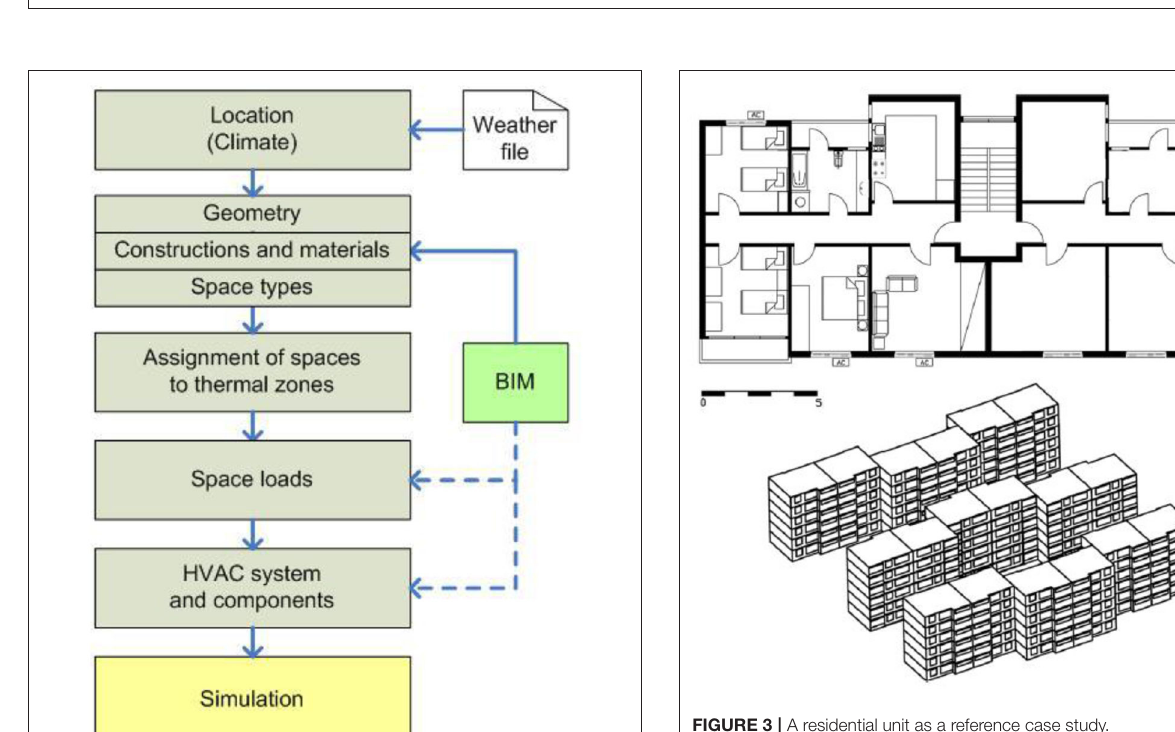
FIGURE 3 | A residential unit as a reference case